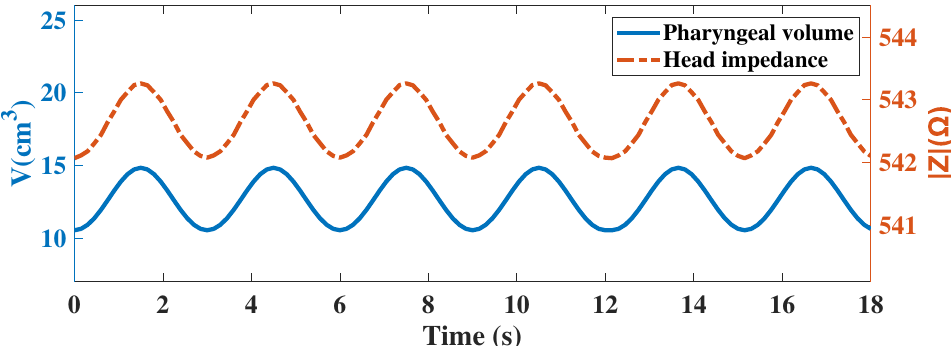
Figure 3. Relationship between pharyngeal volume and head impedance during